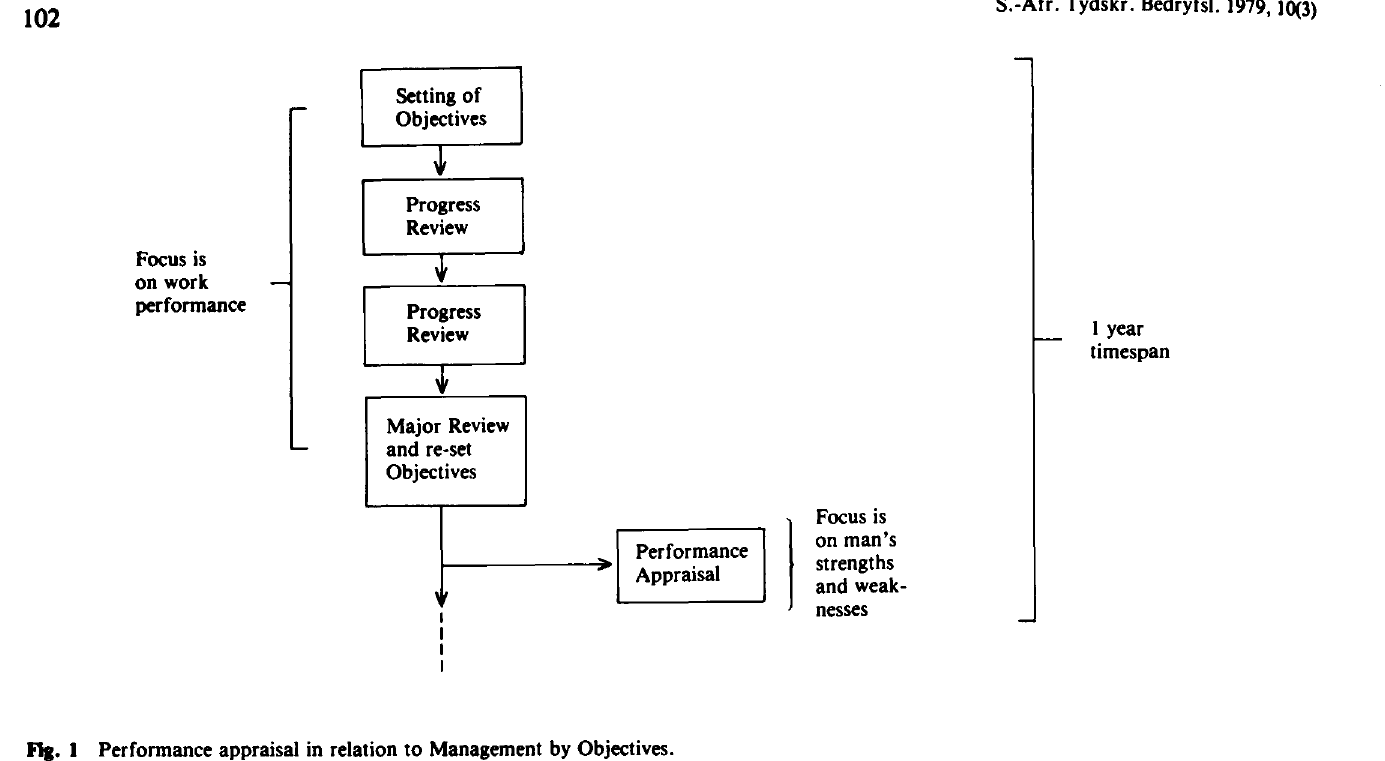
Fig. I Performance appraisal in relation to Management by